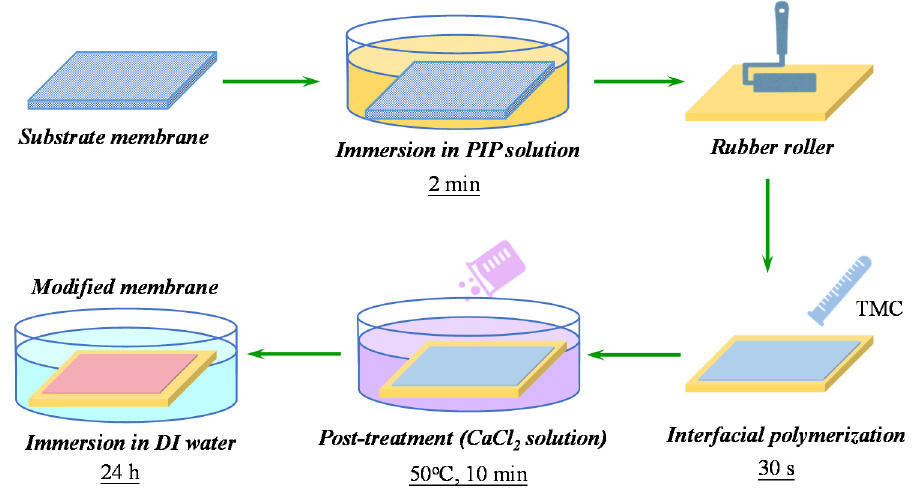
Figure 1. Schematic of the fabrication process of thin-film composite nanofiltration (NF) membrane via dynamic calcium-carboxyl intra-bridging during post-treatment.